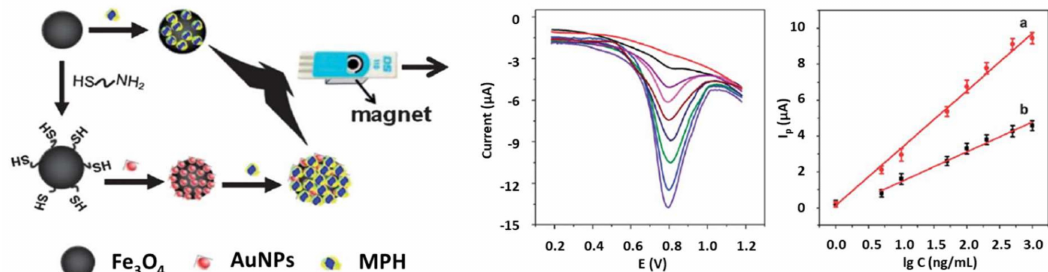
Figure 4. Enzymatic hydrolysis-based biosensors for pesticides detection on screen-printed electrodes. (Left) Scheme of an approach based on the SPCE modification with AuNPs / Fe 3 O 4 NPs for MPH immobilization and further determination of methyl parathion; (Right) SWV measurements of methyl parathion at di ff erent concentrations and calibration plots for the electrode with ( a ) and without ( b ) AuNPs. Reprinted from [151], Copyright 2013, with permission from Royal Society of